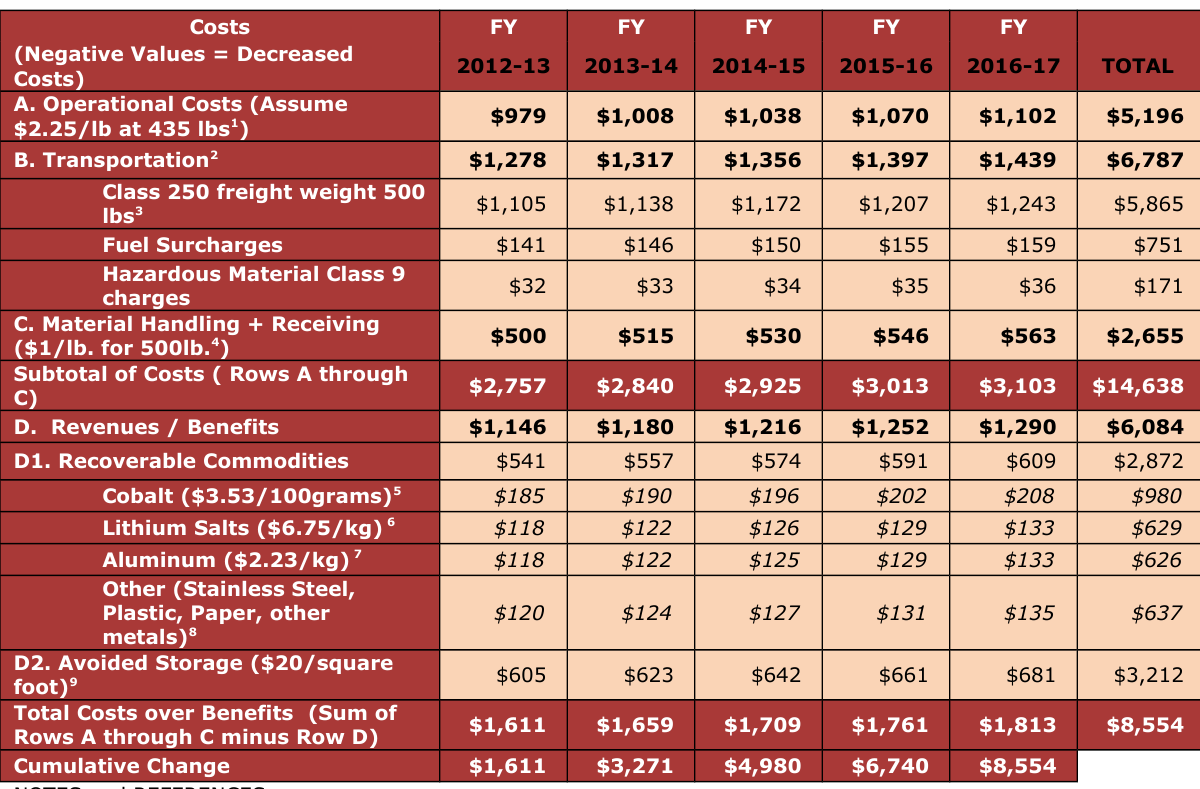
Table 3. Cost Benefit Analysis per Battery for Recycling – Fall 2012 Commodity